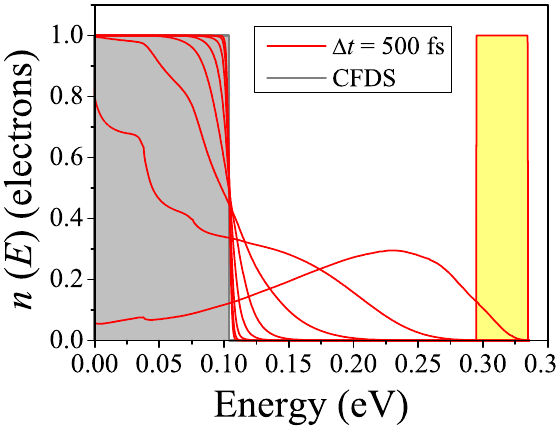
Figure 6. The time evolution of the electron occupations to 4000 fs is given. In the completely Fermi degenerated state (CFDS), the electron occupation corresponds to the Fermi–Dirac distribution at T = 0 K. The energy is referenced from the conduction band minimum